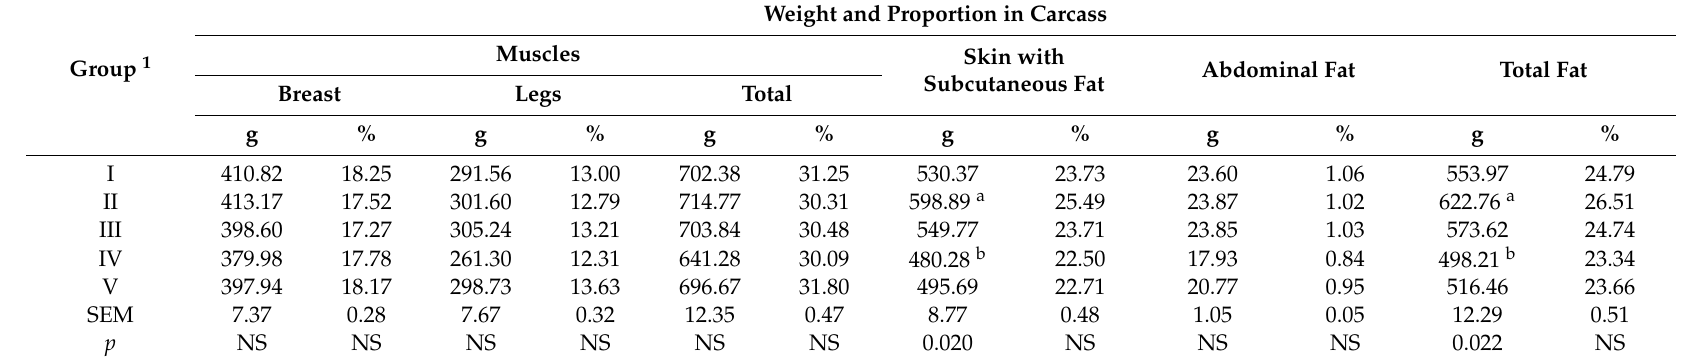
Table 6. Content of muscles and fat in 7-week-old ducks.